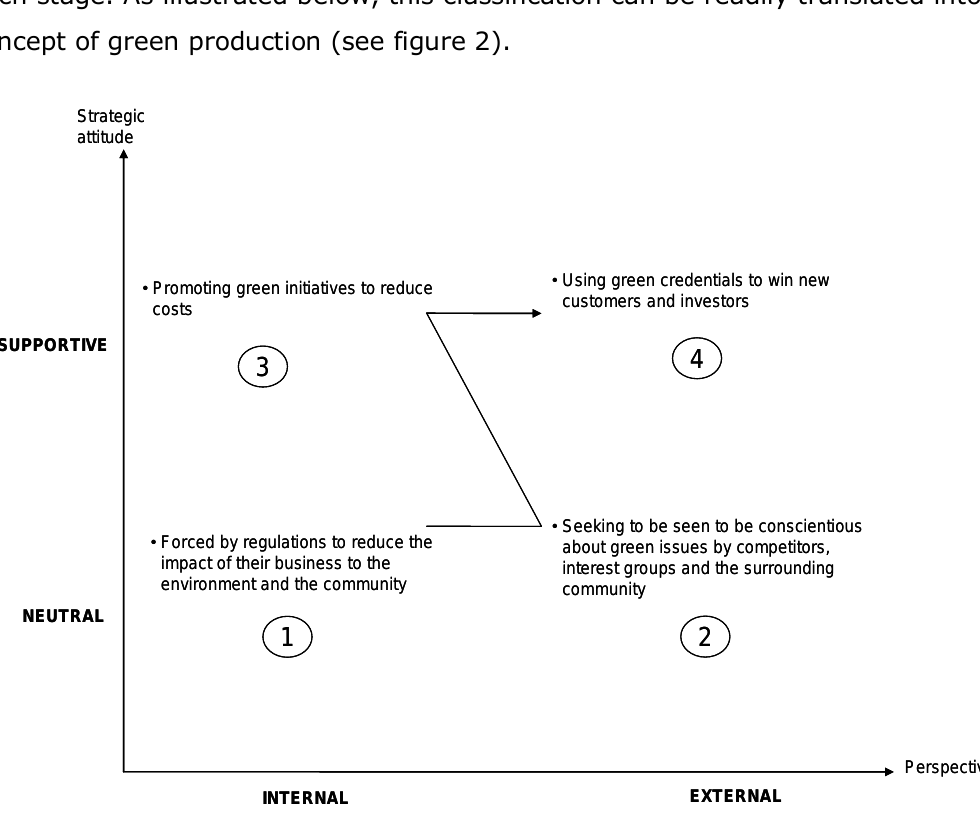
Figure 2. Roles of green production within competitive